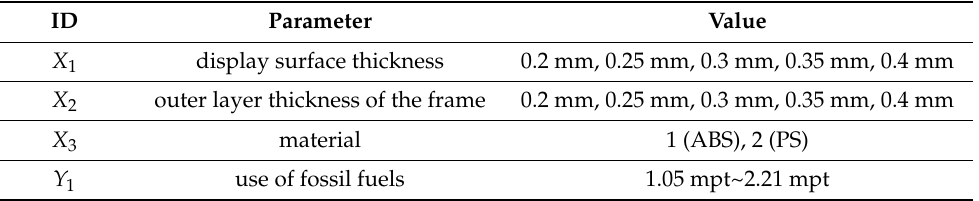
Table 1. Definition of RSM parameters for the environmental impact model.